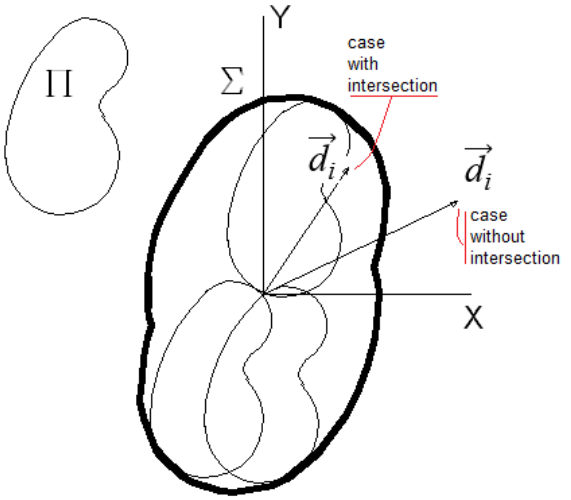
Figure 3. Determination of Σ , auxiliary curve of the intersection criterion and existence of shadow between panels.